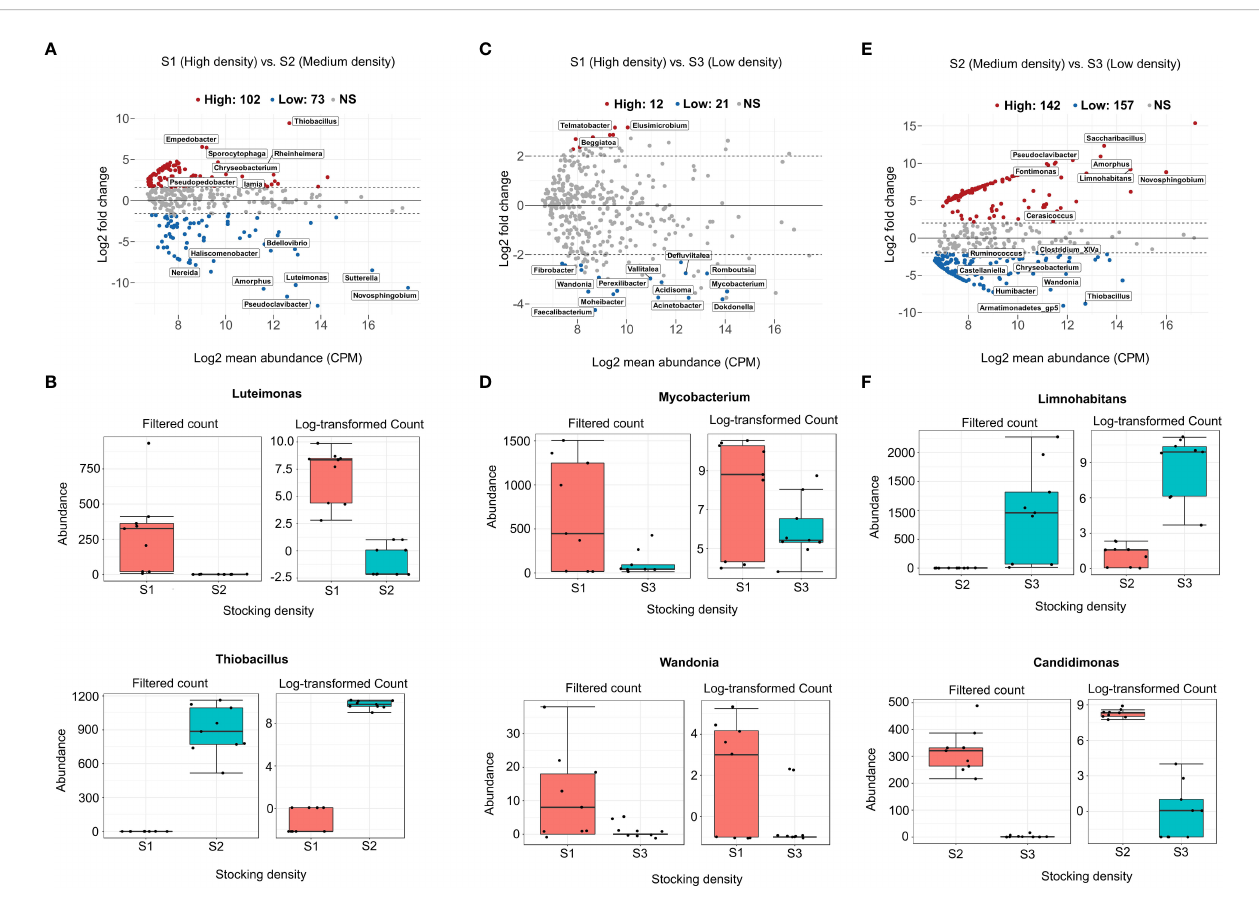
FIGURE 4 The difference in abundance of each genus between stocking density systems was tested using Generalized linear models with FDR 0.05 and logFC > 3. MA plots (A, C) , (E) depict system-wide differential abundance between high (S1) and medium (S2), high (S1) and S3 (low), and medium (S2) and low (S3). Mean relative abundances (CPM) were calculated and plotted against log2 fold changes for all features in each system, including lowly and highly enriched ASVs. (B, D) , (F) are examples of genera that are speci fi c to each stocking density